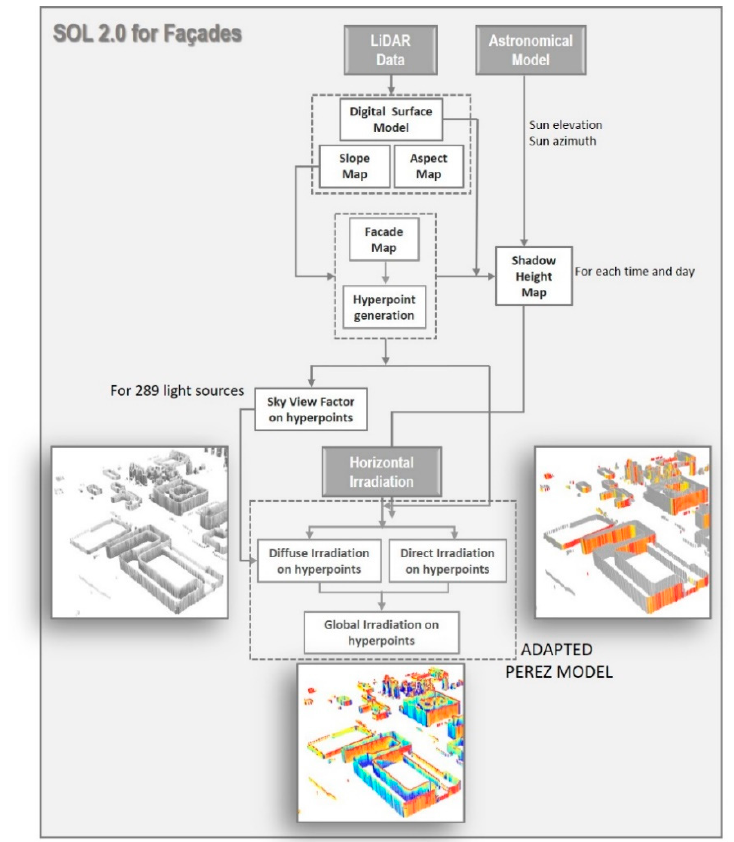
Figure 4. SOL 2.0 workflow for facades.